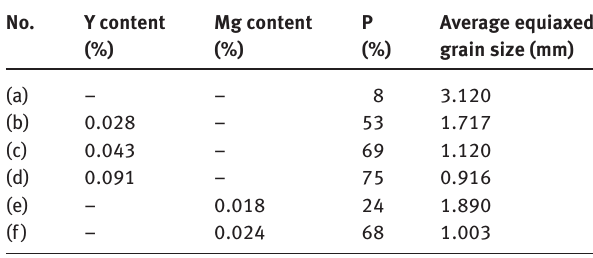
Note: P is the proportion of the equiaxed grains zone at the transverse cross-section.